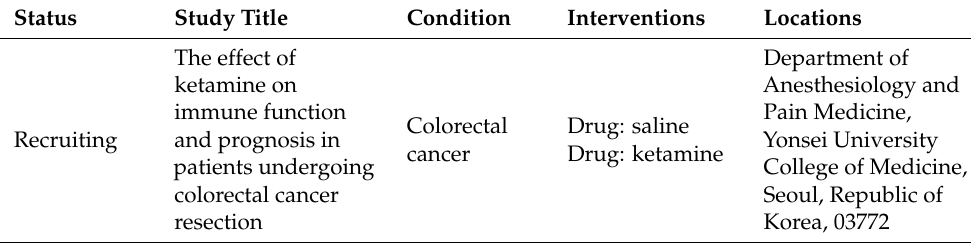
Table 1. A clinical trial of ketamine in the treatment of colorectal